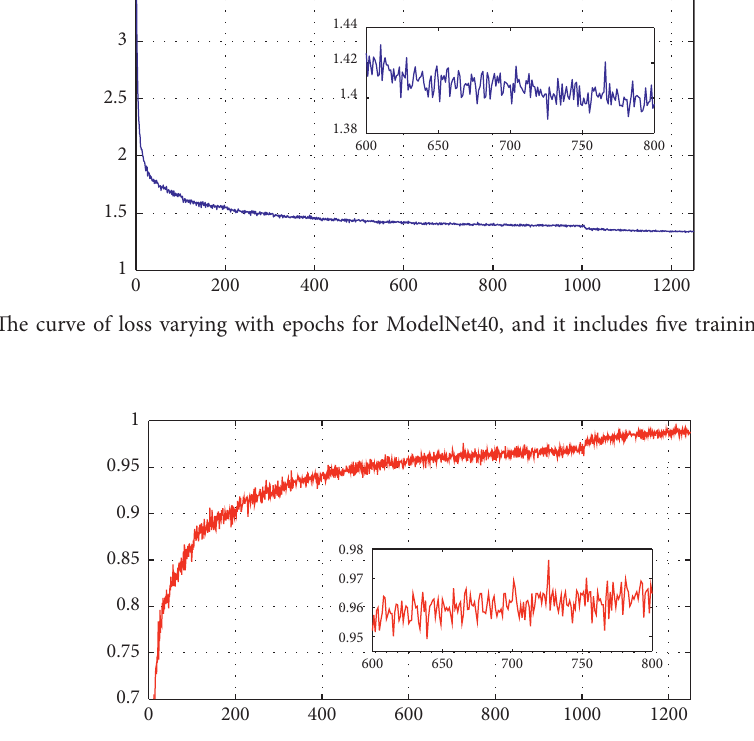
Figure 7: The curve of training accuracy varying with epochs for ModelNet40, and it includes five training in one